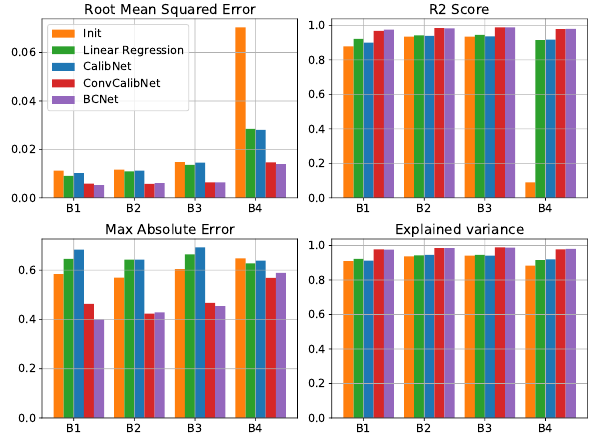
Figure 3. Comparisons of four standard metrics for the initial refletances and the four proposed methods measured on Aude1 dataset.